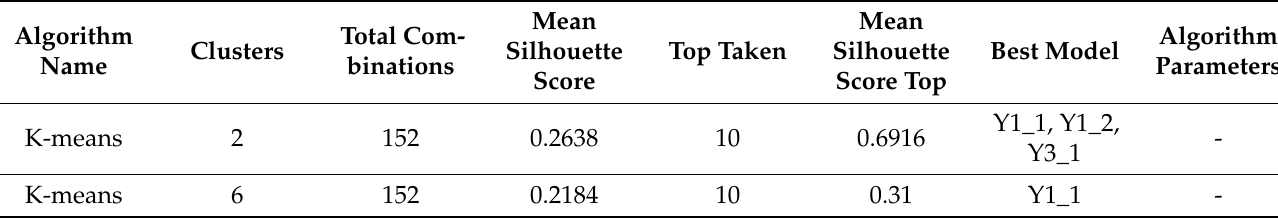
Table A5. Best parameters of each algorithm with the number of clusters used equally to 2, 6, or 10. The algorithm parameters column is empty when the best results depend on the model. The best model column is empty if the best result achieved depended mainly on the method